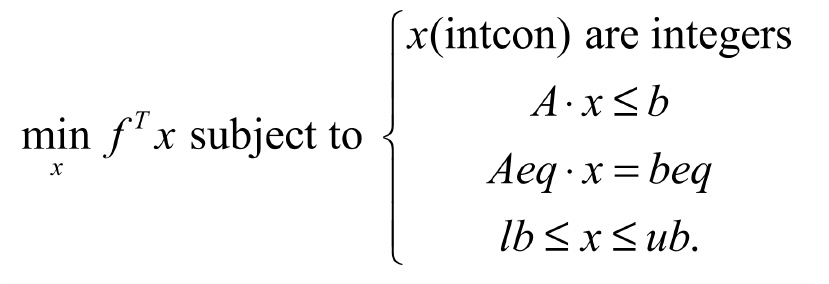
Figure 4. Intlinpro function syntax from MATLAB ®